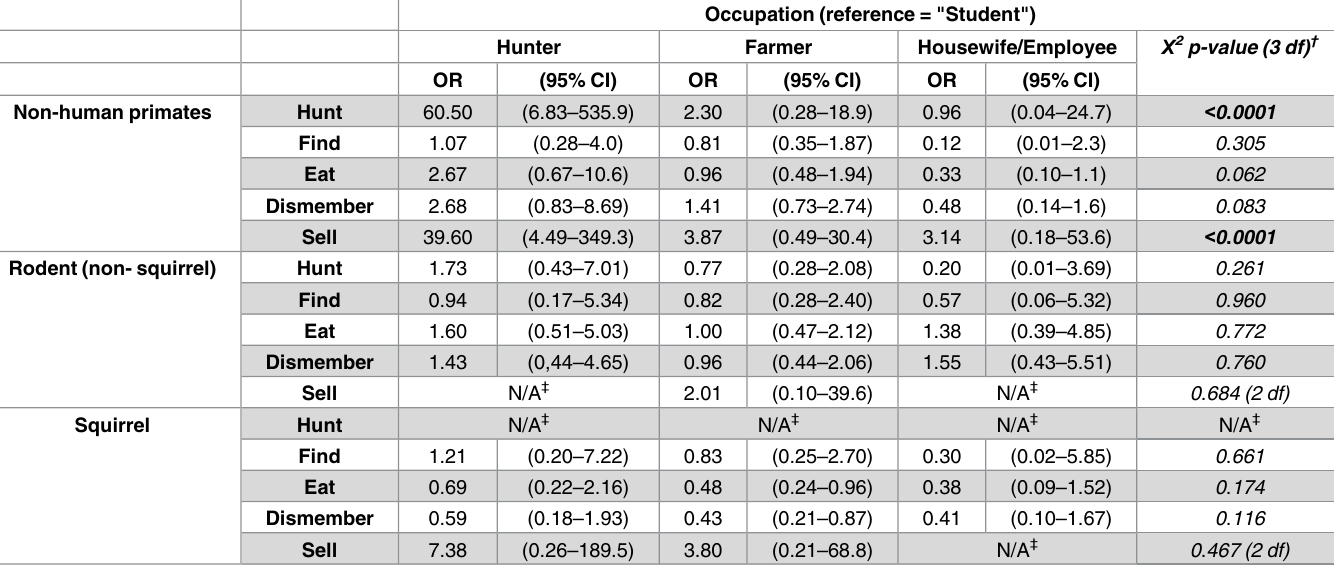
Table 5. Associations of presumptive risk factors for MPXV infection and